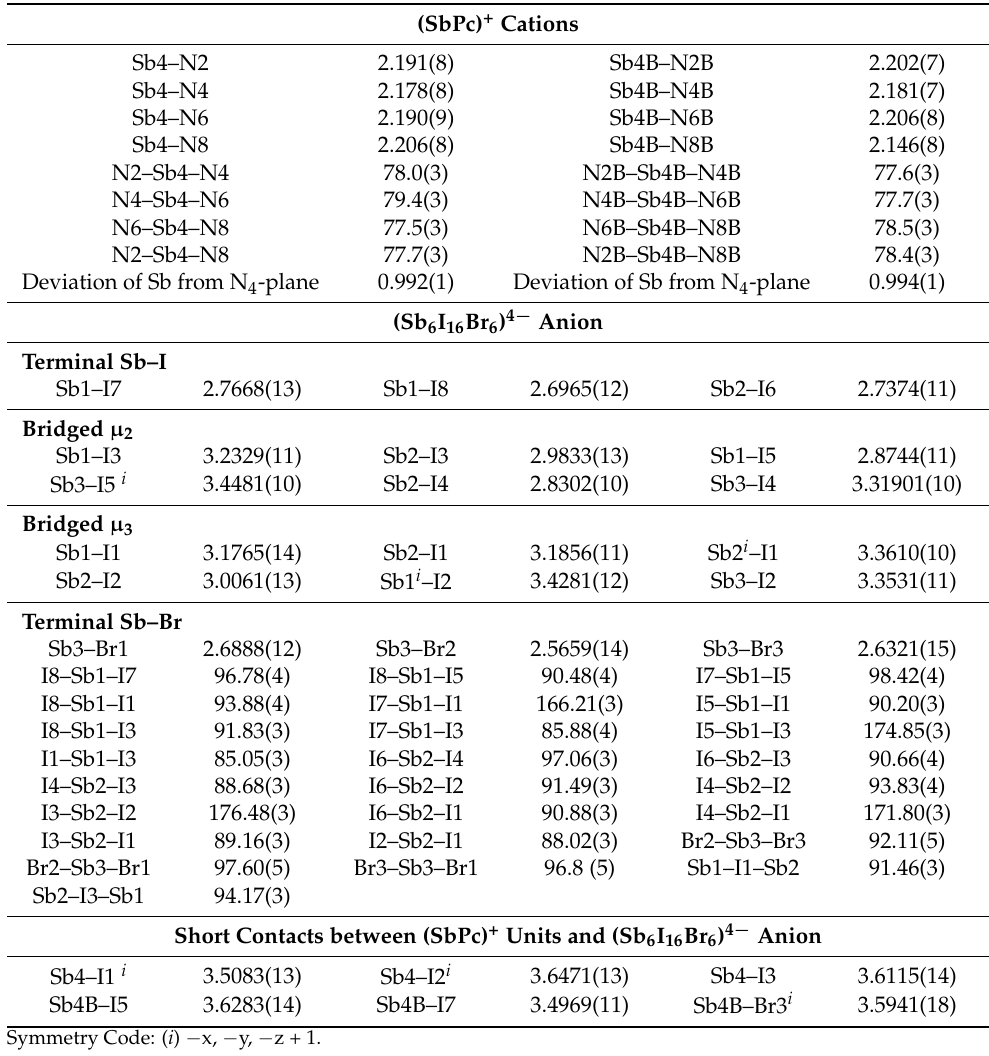
Table 2. Selected bond lengths and angles (Å, ◦ ) in crystal of 1